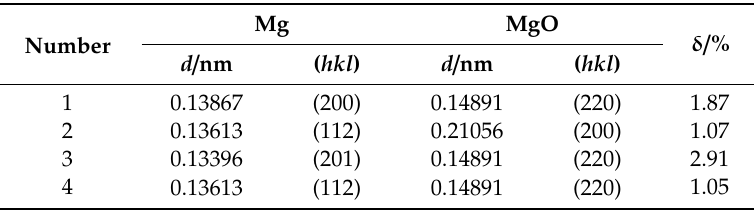
Table 3. Possible coherent interfaces of Mg and MgO.